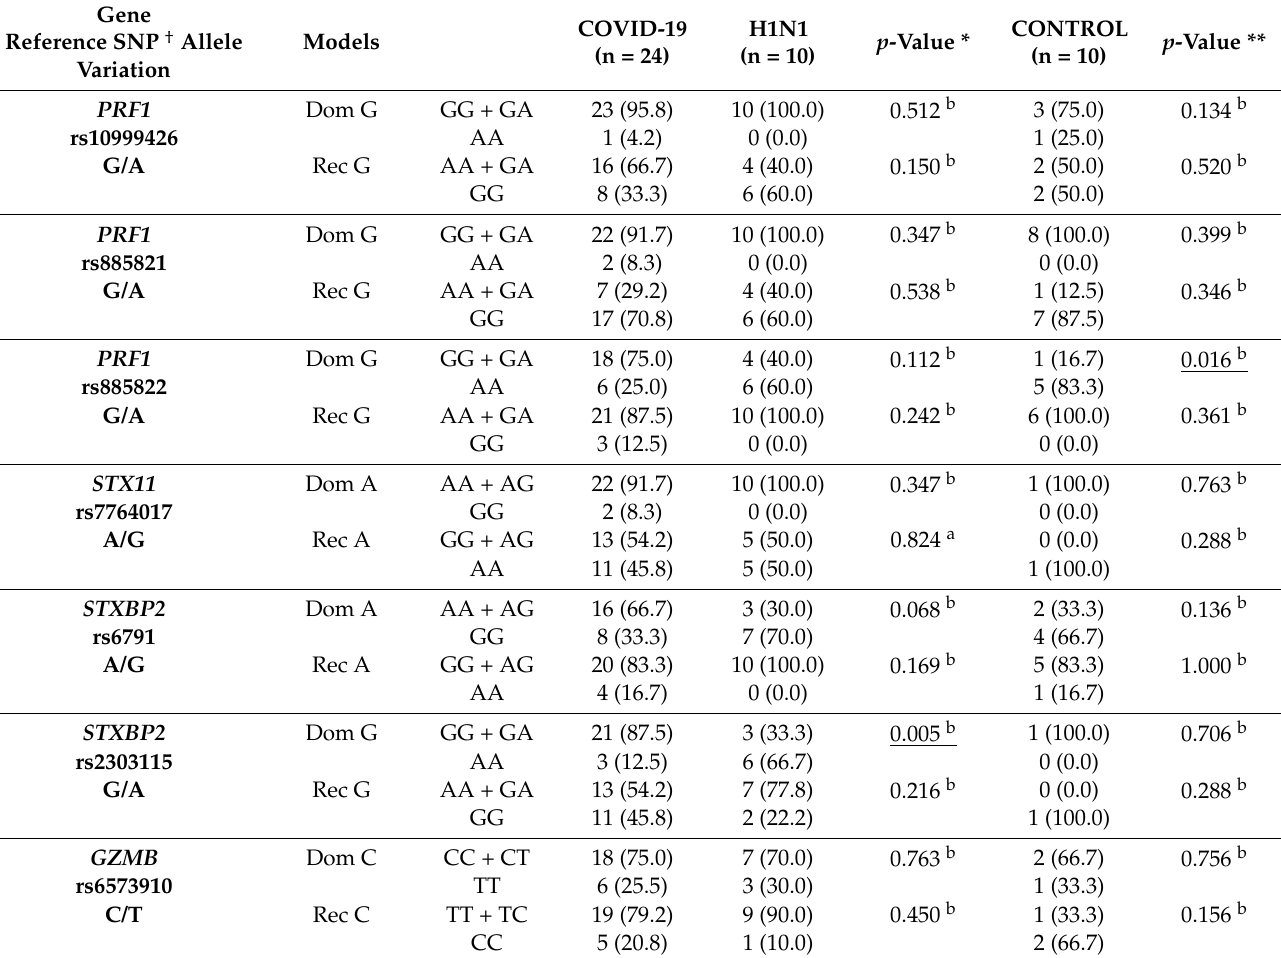
Table 3. Genotypic distribution for PRF1, STX11, STXBP2 and GZMB genes in dominant and recessive